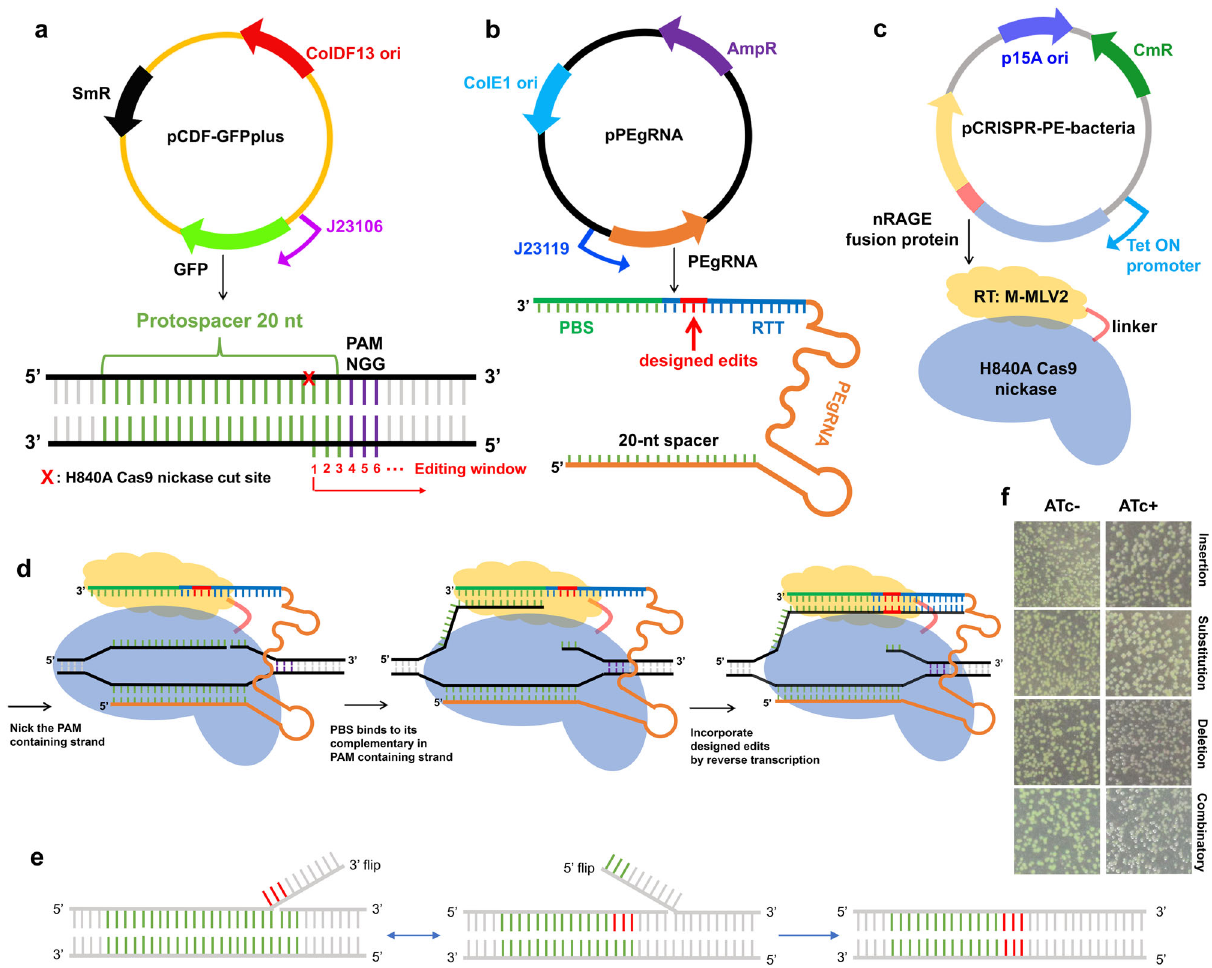
Fig. 1 A three-plasmid system for evaluation of CRISPR-Prime Editing system in E. coli . a The plasmid map of the reporter vector pCDF-GFPplus, which carries a constitutive promoter J23106 driving expression of fast folding GFP. The plasmid contains a spectinomycin-resistance (SmR) gene, and the ColDF13 origin (ori). An illustration of the target DNA composition is shown below the plasmid map. b The plasmid map of the PEgRNA transcript bearing vector, which contains the ColE1 ori and an ampicillin-resistance (AmpR) gene for selection. The PEgRNA transcript is under control of the constitutive promoter J23119. A detailed structure is shown beneath, the 3 ′ extension sequence is composed of a PBS (in green) and a RTT (in blue), which carries the intended edits (in red). c Plasmid map of the CRISPR-PE-bacteria vector, which carries a p15A ori and a chloramphenicol-resistance gene (CmR) for selection. The E. coli codon optimized, tetracycline inducible promoter driven Cas9n-M-MLV2 fusion protein consists of a H840A Cas9 nickase (Cas9n), a 33-aa fl exible linker, and a moloney murine leukemia virus (M-MLV) variant M-MLV2, described previously 19 with the following mutations: D200N, L603W, T306K, W313F, and T330P compared to the WT M-MLV (GenBank: AAC82568.2). d A schematic model for DNA engineering with CRISPR-Prime Editing system for E. coli . After being expressed, the Cas9n-M-MLV2:PEgRNA complex binds to the targeted DNA sequence in a sgRNA-dependent and PAM-dependent manner. The Cas9n domain within the fusion protein nicks the PAM-containing strand, freeing the adjacent DNA sequence. Subsequently, this piece of single stranded DNA hybridizes to the PBS, then primes reverse transcription of new DNA containing the designed edits based on the RTT within the 3 ′ -extension of the PEgRNA transcript. e Two possible consequences of CRISPR-Prime Editing. It normally has an equilibration between the edited 3 ′ fl ap and the unedited 5 ′ fl ap, only the cleavage of the 5 ′ fl ap leads to the desired editing. f Colony views of E. coli strains transformed with CRISPR- Prime Editing systems carrying designed edits of TAA insertion, T to A substitution, T deletion and the combinatorial edits with and without 200 ng/mL ATc induction using a Doc-It imaging station, non-green colonies appeared after 24 h induction of 200 ng/mL RNA-protein complex, the Cas9n-component of the complex As a proof of concept, we transformed E. coli cells with subsequently fi nds its target DNA sequence and introduces a nick CRISPR-Prime Editing systems programmed for TAA (3-bp) in the PAM containing DNA strand. The PBS within the 3 ′ insertion, T to A (1-bp) substitution, T (1-bp) deletion, and the extension then binds to the fl ipped PAM containing DNA sequence, initiating the reverse transcription to elongate the nicked DNA sequence based on the sequence of the RTT gene (Supplementary Table 4). Growth pro fi ling of E. coli strains (Fig. 1d). After the reverse transcription process, the nicked bearing different plasmids with and without induction indicated double stranded DNA hypothetically undergoes an equilibration that almost no changes in fi tness were caused by non-targeting between the edited 3 ′ fl ap and the unedited 5 ′ fl ap. The cleavage CRISPR-Prime Editing system (Supplementary Table 5). How- of the unedited 5 ′ fl ap then leads to the desired DNA editing 19 ever, a mild negative effect of around 10% on growth (maximal (Fig. 1e). doubling time) due to the 200 ng/mL anhydrotetracycline (ATc)